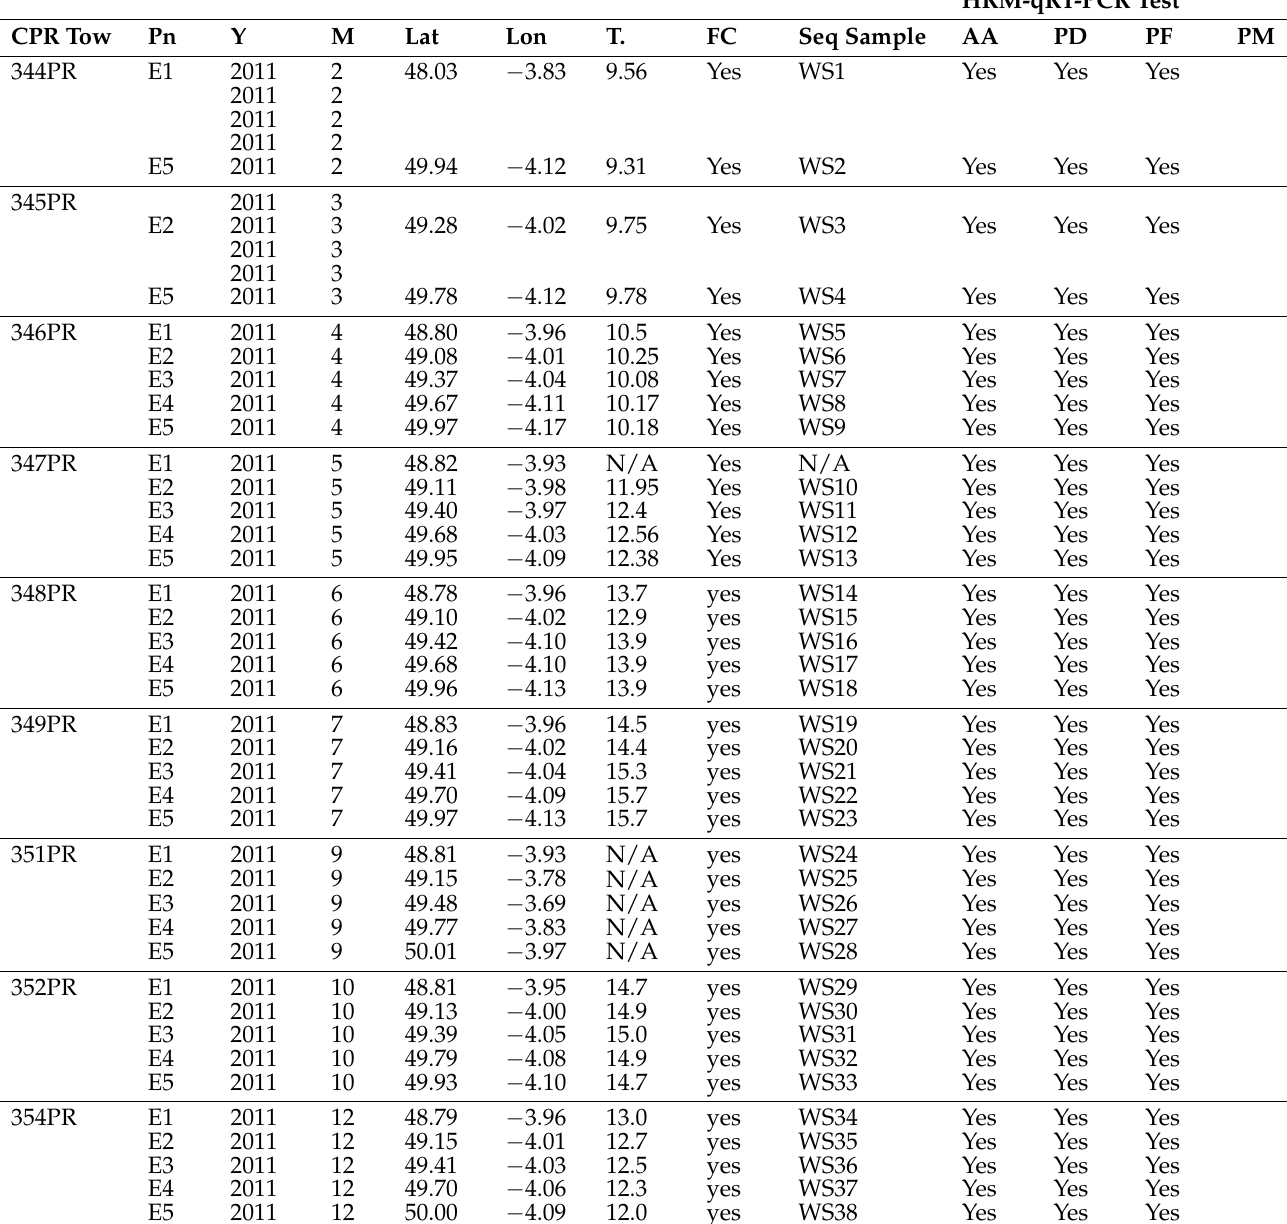
Table 2. Summary of Samples taken in the English Channel from 2011–2013 using the WaMS deployed within the CPR sampling platform and tests carried out on them. All CPR tow samples will have microscopic plankton semi-quantitative abundance. Empty positions indicate no samples were available to analyze. No samples were taken in August and November 2011, April 2012, March, April and October 2013. Positions E1–E5 denote sample positions taken progressively from Roscoff, France to Plymouth, UK. Blue-type sample positions were not collected, so they were inferred from the timing of previous deployments. Pn: Position, Y: Year, M: month, Lat: Latitude, Lon: Longitude, In situ T: In situ temperature, FC: Flow cytometry. AA: A. anophagefferens , PD: P. delicatissima , PF P. fraudulenta , PM: P. multiseries